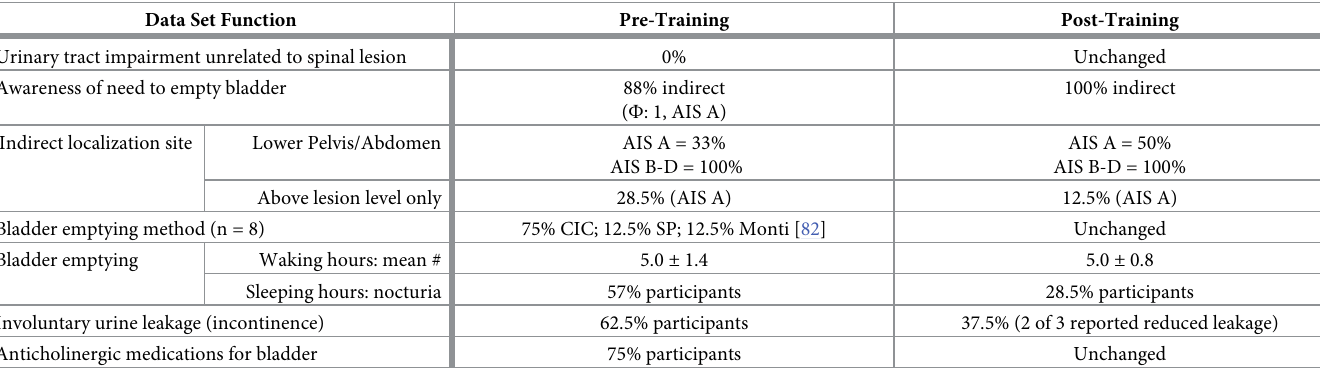
Table 2. LUT elements adapted from international SCI data set